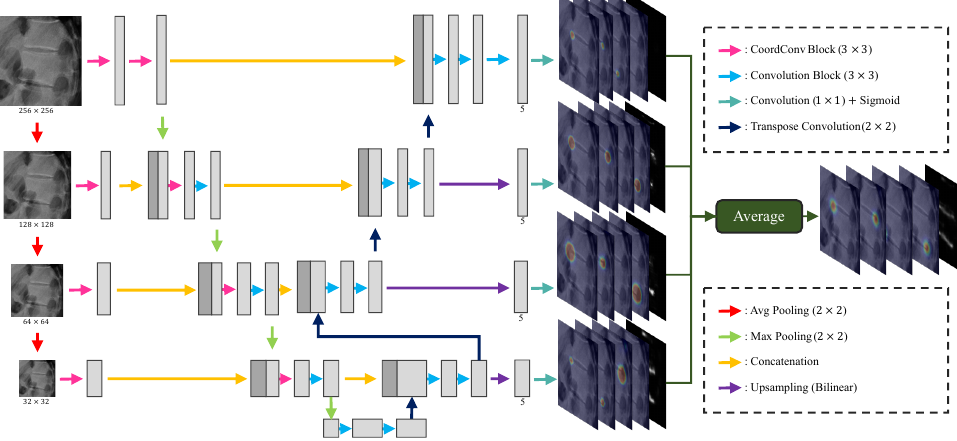
Figure 8. An overview of our proposed M-Net. In each resolution, the channel of all features except the channel (5) of the last feature is the same as Kim et al. [5].